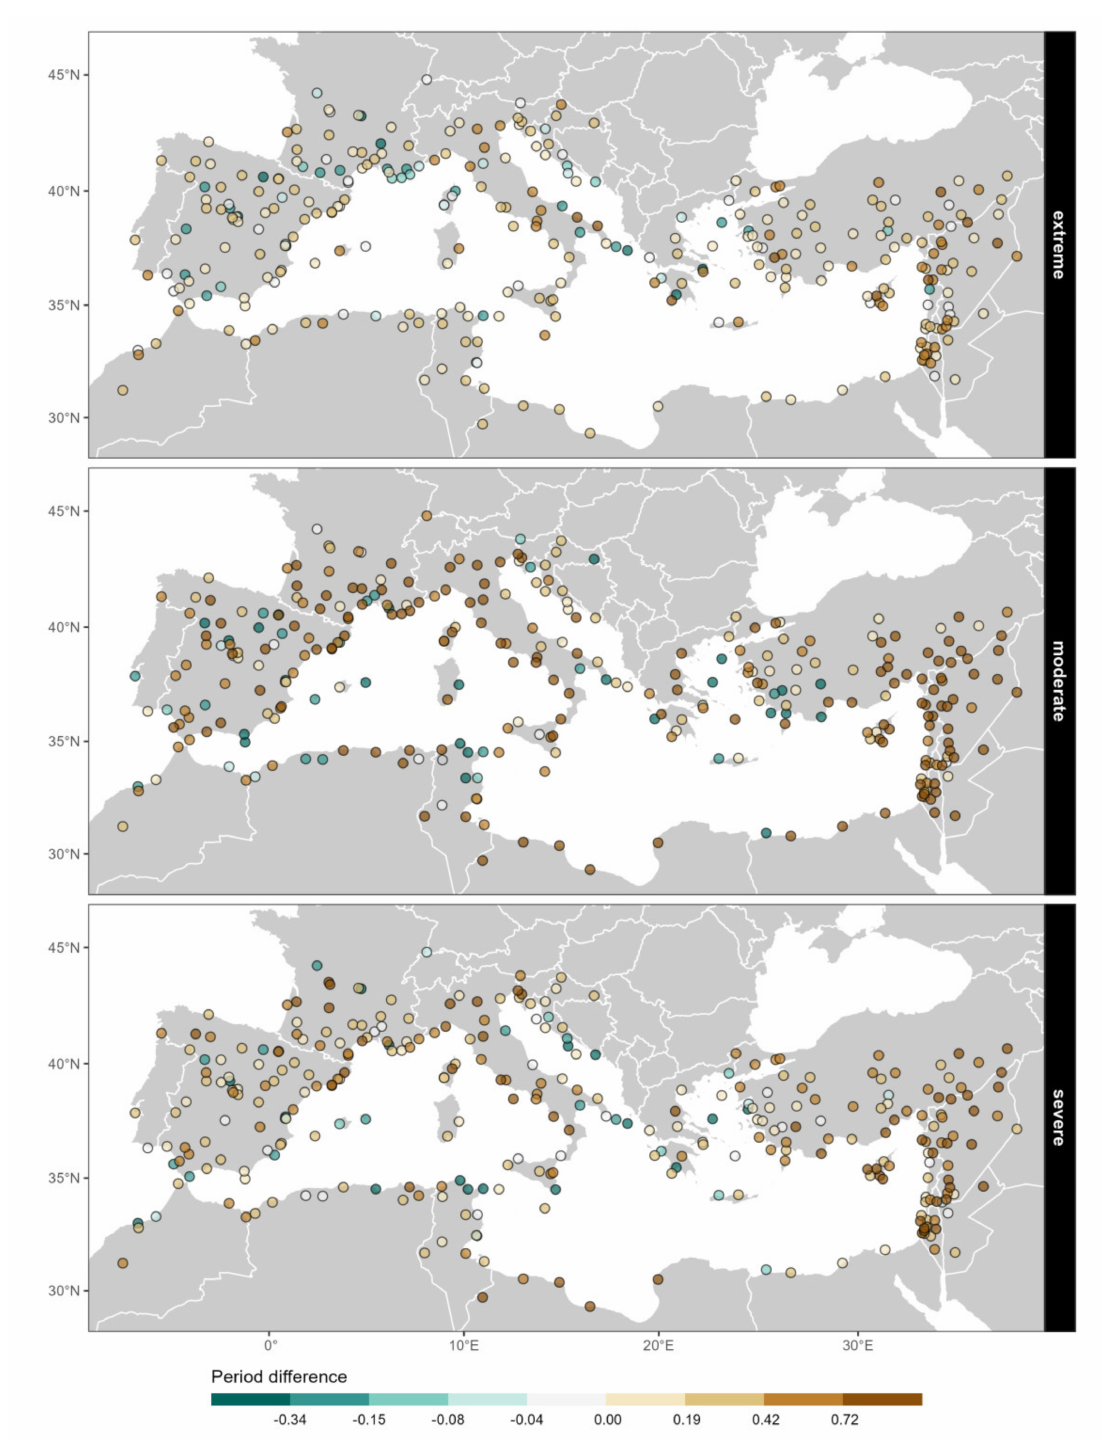
Figure 6. The expressed difference (per decade) of extreme, severe and moderate drought frequency (DRF) between 1975–1996 and 1997–2019 based on